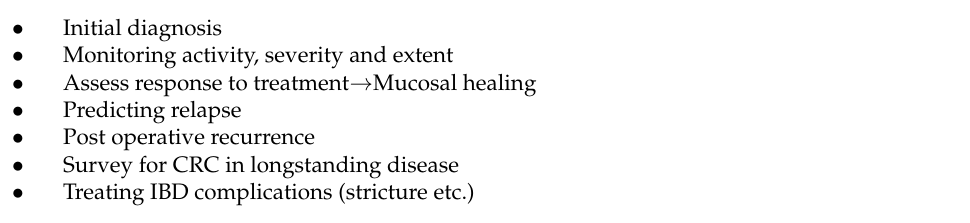
Table 1. When do we usually employ endoscopy in Crohn’s